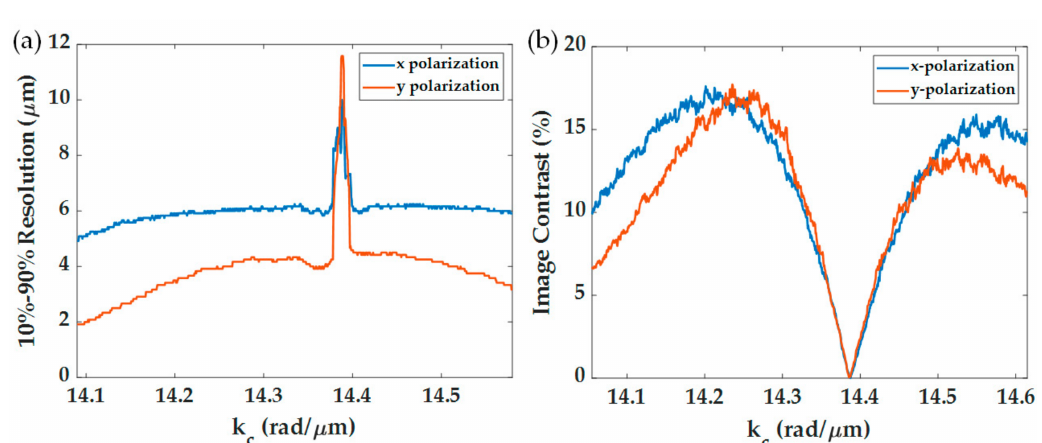
Figure 10. ( a ) 10–90% spatial resolution for x-polarization and y-polarization calculated from Figure 9b–e, and ( b ) image contrast in percentage for x-polarization and y-polarization calculated from Figure 9c–f using Equation (12). Note that the x-polarization is shown in blue curves, and the y-polarization is shown in red